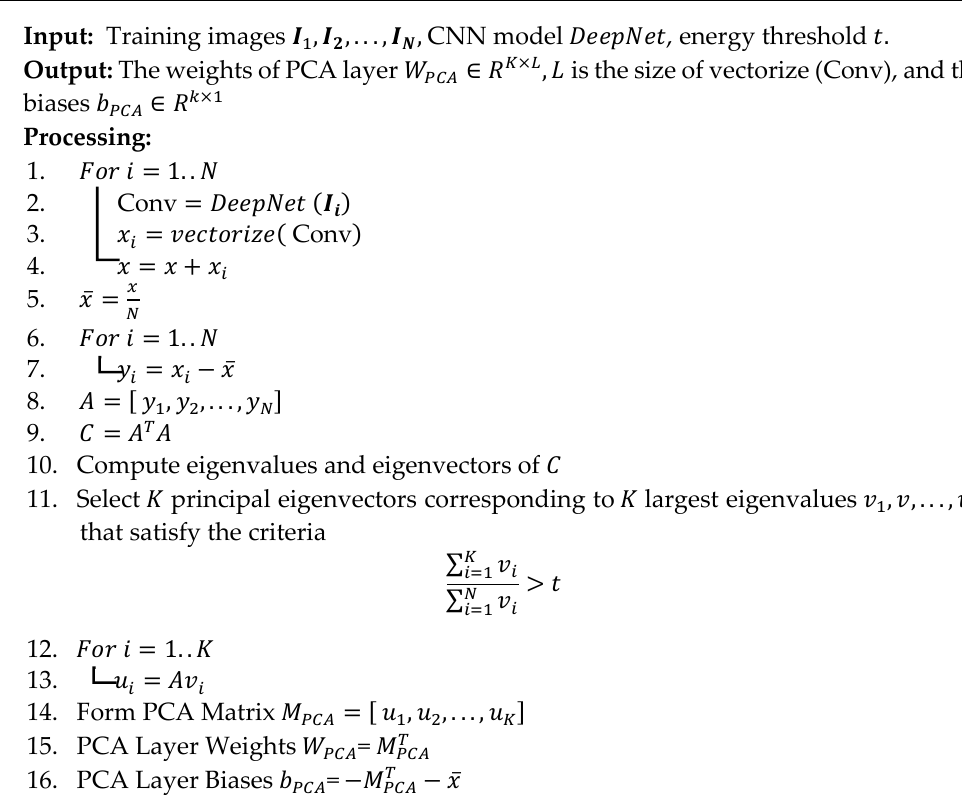
Algorithm 1: PCA Layer—Weights Computation